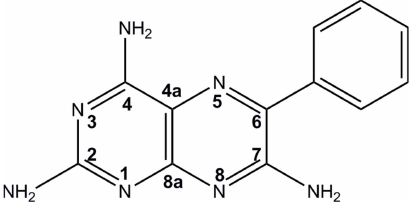
Figure 1 Chemical diagram of 1 labelled with the numbering scheme that is used throughout this manuscript.